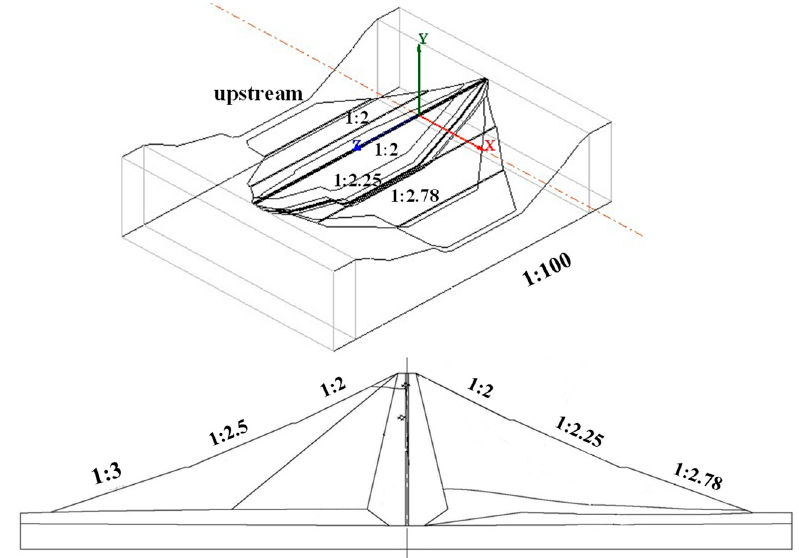
Figure 4. Main dam body and the dam x-section.